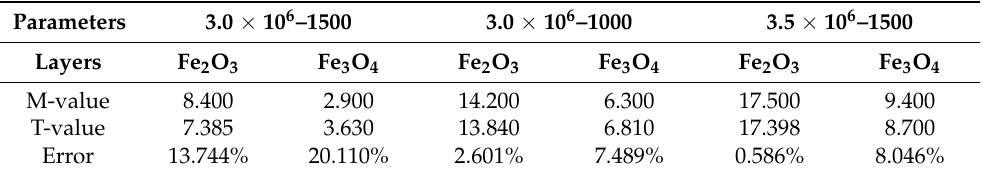
Table 6. Comparative analysis of measurements and under different